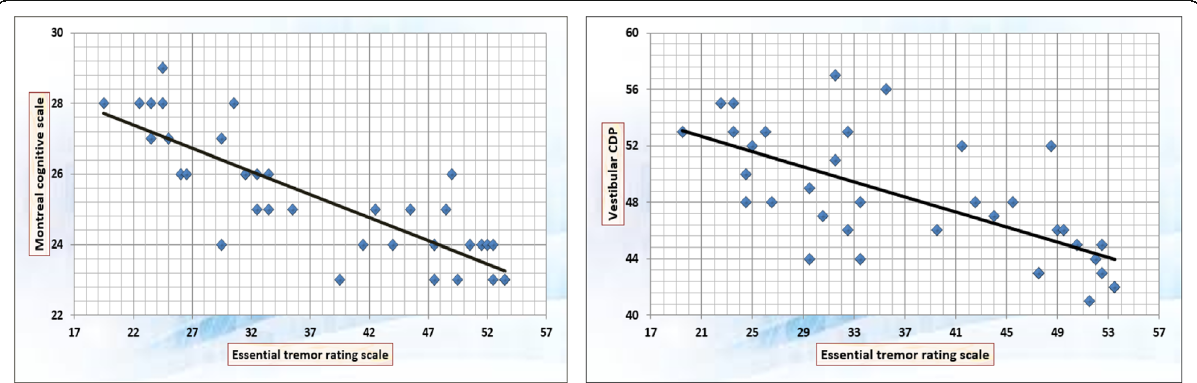
Fig. 3 Negative correlation between the essential tremor rating assessment scale and each of Montreal cognitive assessment scale (left) as well as vestibular computerized dynamic posturography ratio